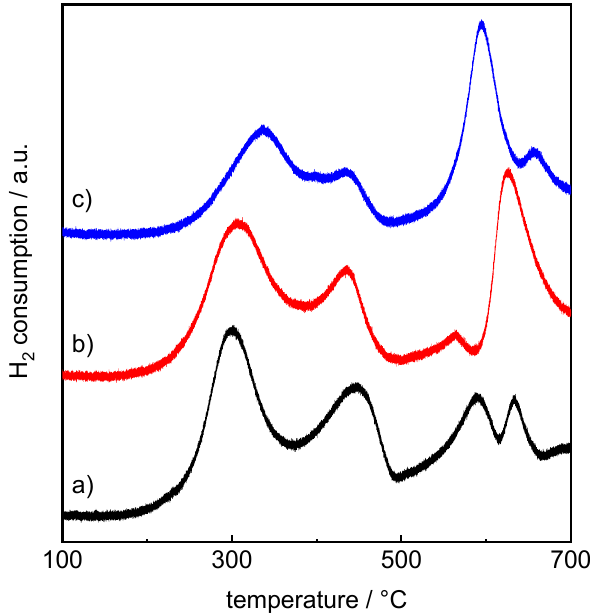
Figure 5. TPR patterns of selected as-made Fe@SiO 2 core-shell particles after initial drying at 200 °C in Ar flow (heating rate 2 K/min, 50 mL STP /min Ar) for 2 h: (a) 13Fe(8)@SiO 2 , (b) 15Fe(6)@SiO 2 , and (c) 15Fe(4)@SiO 2 .